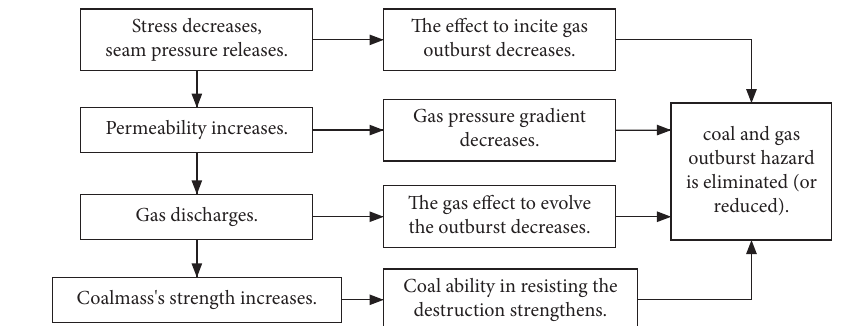
Figure 4: Outburst prevention principle with the protective seam mining.